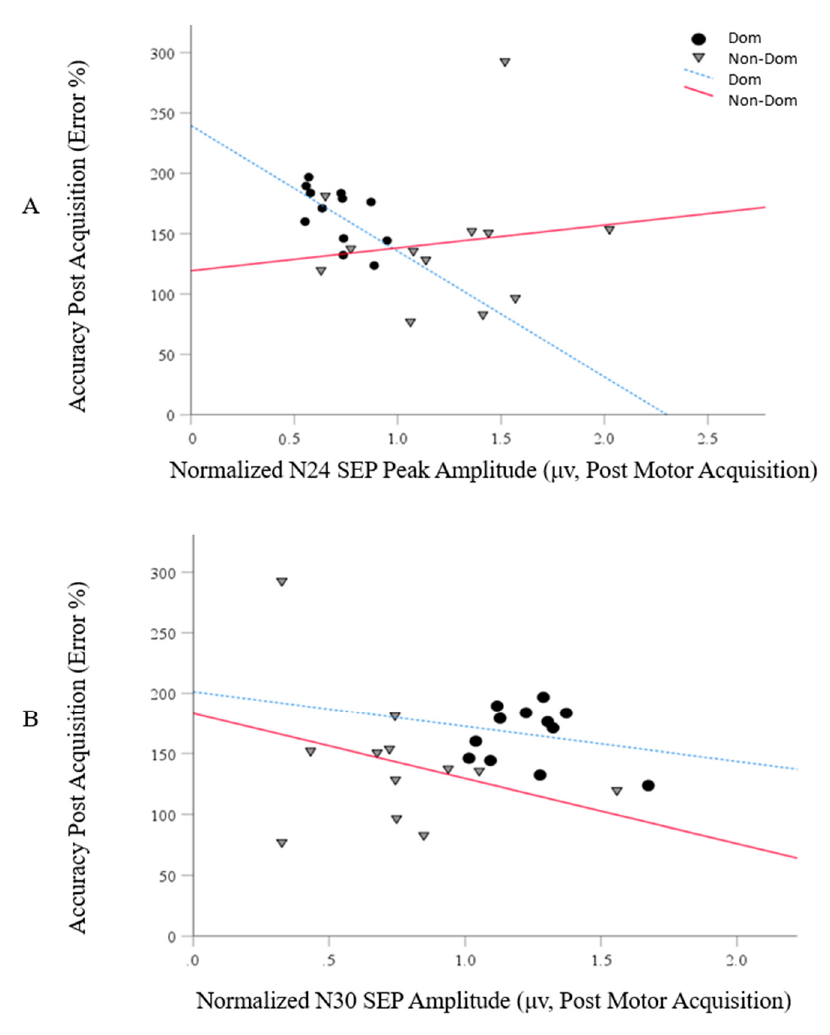
Figure 7. Graphical representations of the correlations for SEP peaks. Panel ( A ) is for the N24 and panel ( B ) is for the N30.